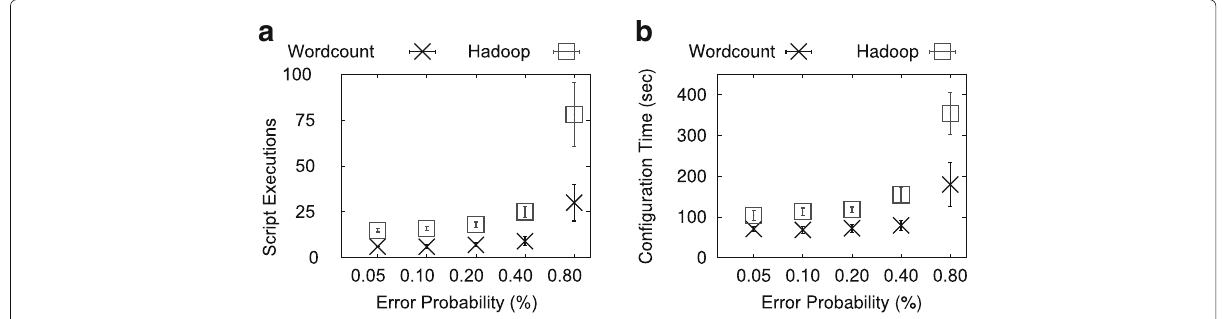
Fig. 9 Number of script executions and configuration times for varying error probability. a Script Executions. b Configuration